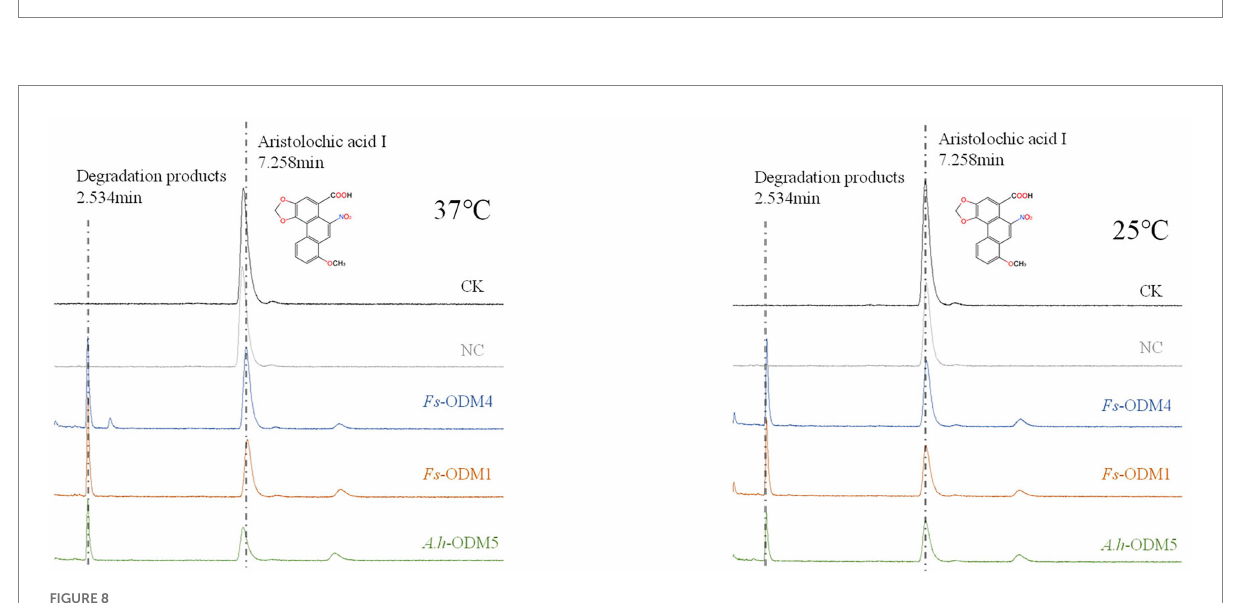
FIGURE 8 UPLC profile of AAI degraded by ODMs enzyme at 37 ° C (left) and 25 ° C (right). The degradation efficiency of three ODMs is shown in Supplementary Table